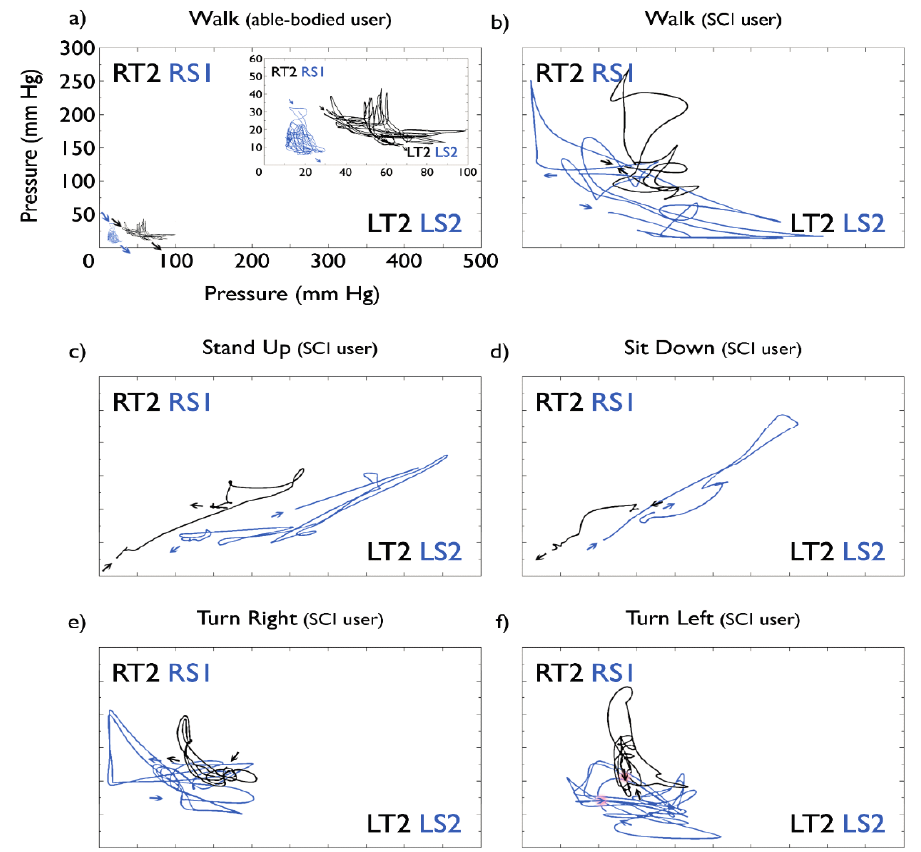
Figure 6. Pressure measured on Right Thigh compared to Left Thigh (black) and Right Shin compared to Left Shin (blue). Sensor pairs with representative interactions were